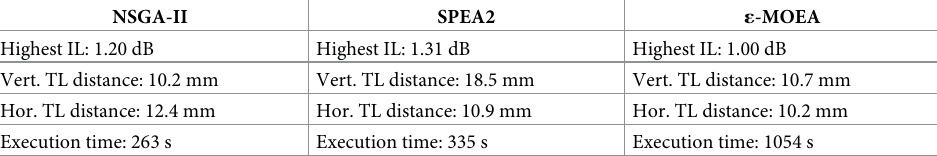
Table 2. Overall performance of the optimization algorithms for the 32 x 16 multi-nuclear switch matrix design (IL–insertion loss, TL–transmission